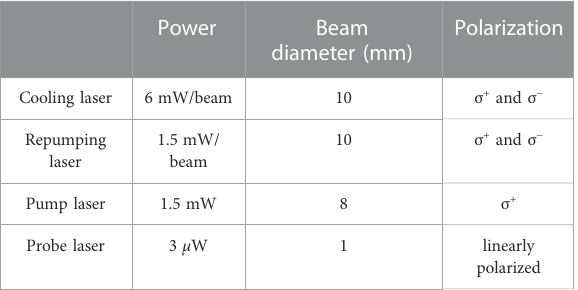
TABLE 1 Power, Beam diameter, and polarization of the Cooling, Repumping, Pump, and Probe lasers.